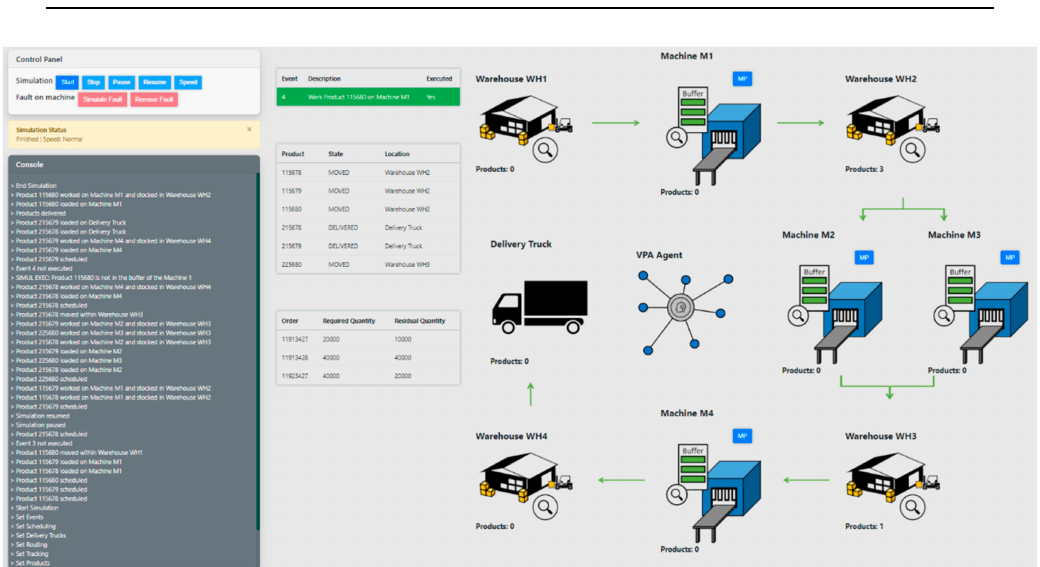
Figure 13. Machine overloading scenario at the end of the